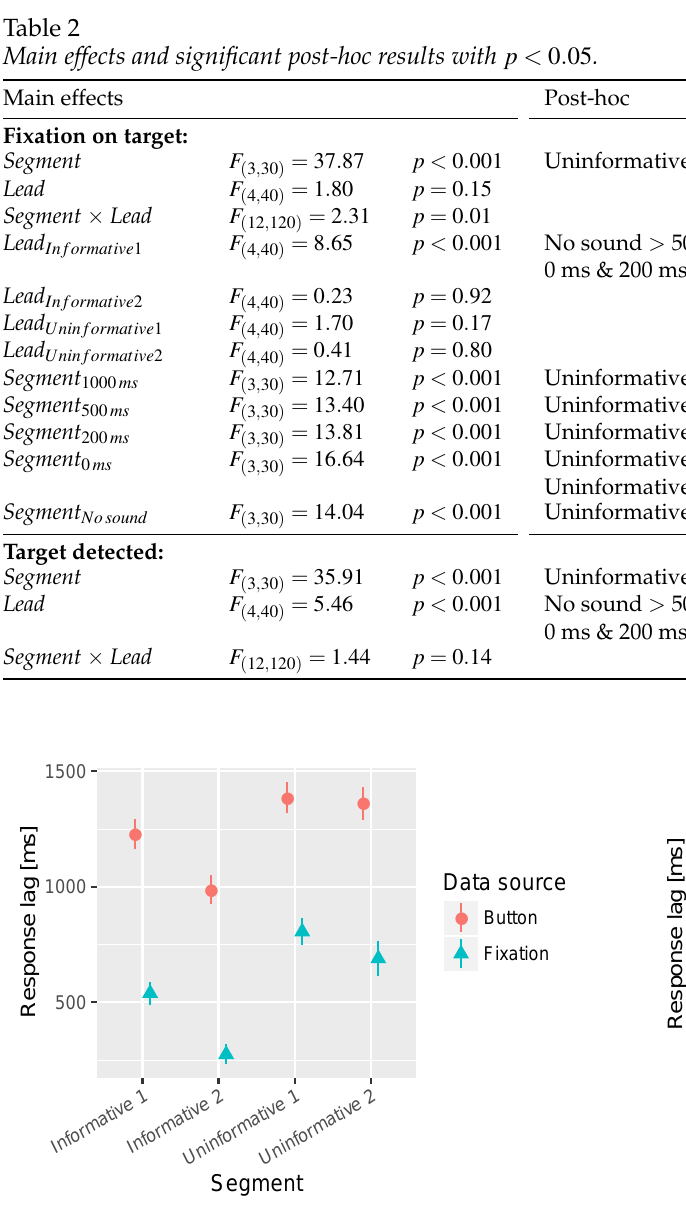
Figure 6 . Combined mean times to first fixation on target and button press for the different audio lead times. All segments are collapsed together in this analysis. The bars represent the 95 % confidence intervals of the